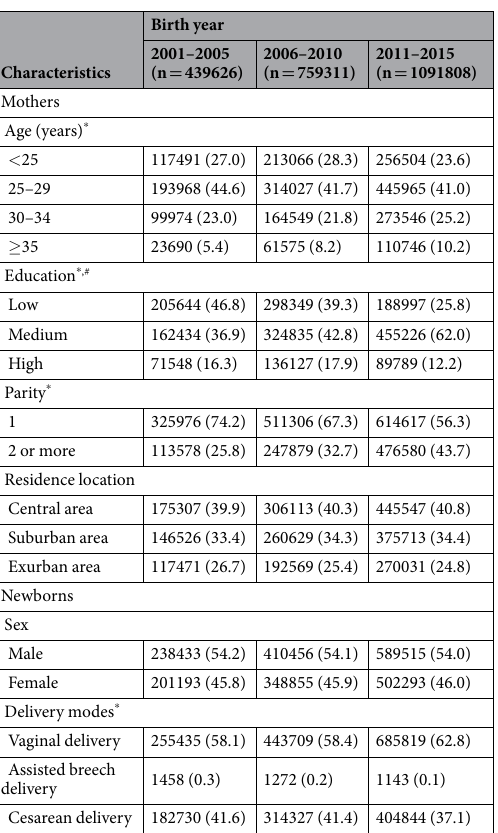
Table 1. Maternal and newborn characteristics among singleton live births in Guangzhou, China from 2001 to 2015. Data are expressed as n (%). * Missing data: maternal age (n = 15,907), education (n = 357,796), parity (n = 809) and delivery modes (n = 8). # Education: low (junior school or less), medium (high school), high (College or